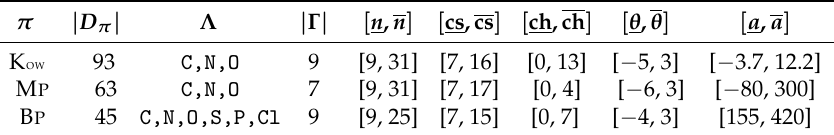
Table 1. Results of Step 1 in Phase 1.